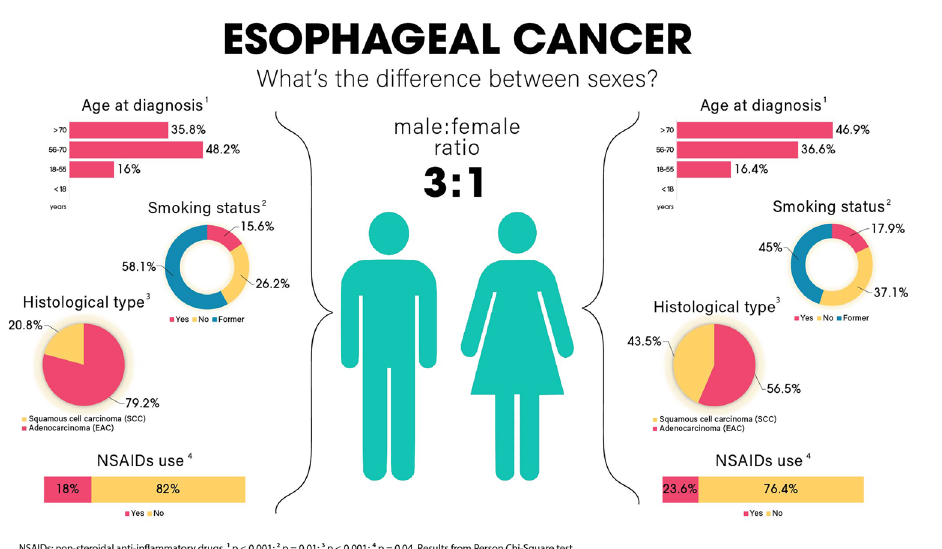
Figure 4. Sex differences for esophageal cancer overall. Higher in males (3:1 ratio) and statistical differences for age at diagnosis (p < 0.001), smoking status (p = 0.01), histological subtype (p < 0.001) and NSAIDs use (p = 0.04), UH Seidman Cancer Center Database